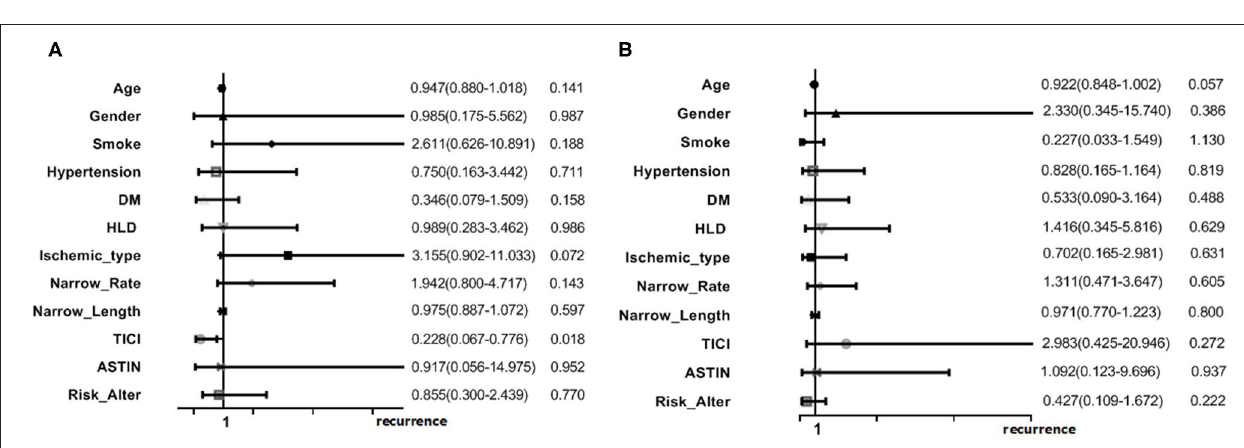
FIGURE 4 | Multivariate analysis in posterior (A) and anterior (B) circulation